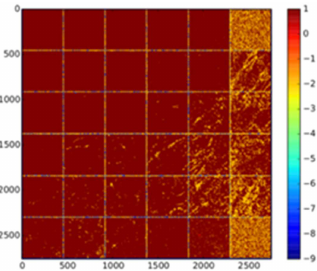
Figure 6 : Medicis validity flags obtained with the same parameters as the one used by Rosu et al. and detailed in Figure 5. The Medicis V9.1 validity flag values are integers included in [-9; 1], 1 representing a valid pixel. 9.85% of the pixels were flagged -2 by Medicis (-2 corresponding to the “exploration area edge” validity flag), which means that the maximum found at pixel step was on the exploration area edge and that the calculations stopped at pixel step. Most of these -2 invalid pixels being inside the blocks, it means that there is a trouble in the exploration area.